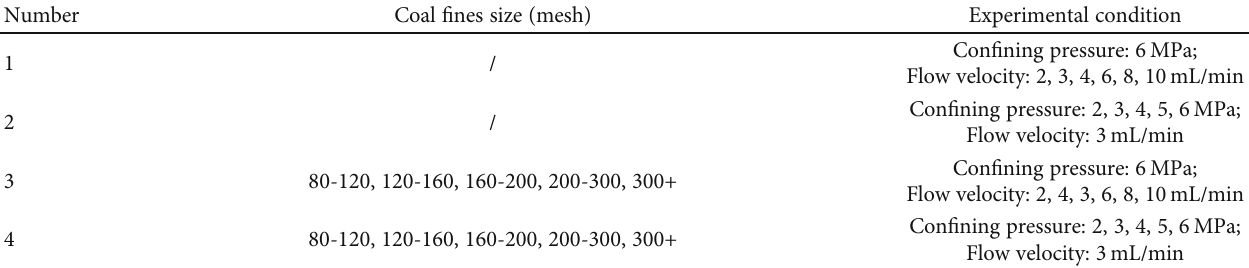
Table 2: The coal fi nes intrusion experimental conditions of single-phase water fl ow